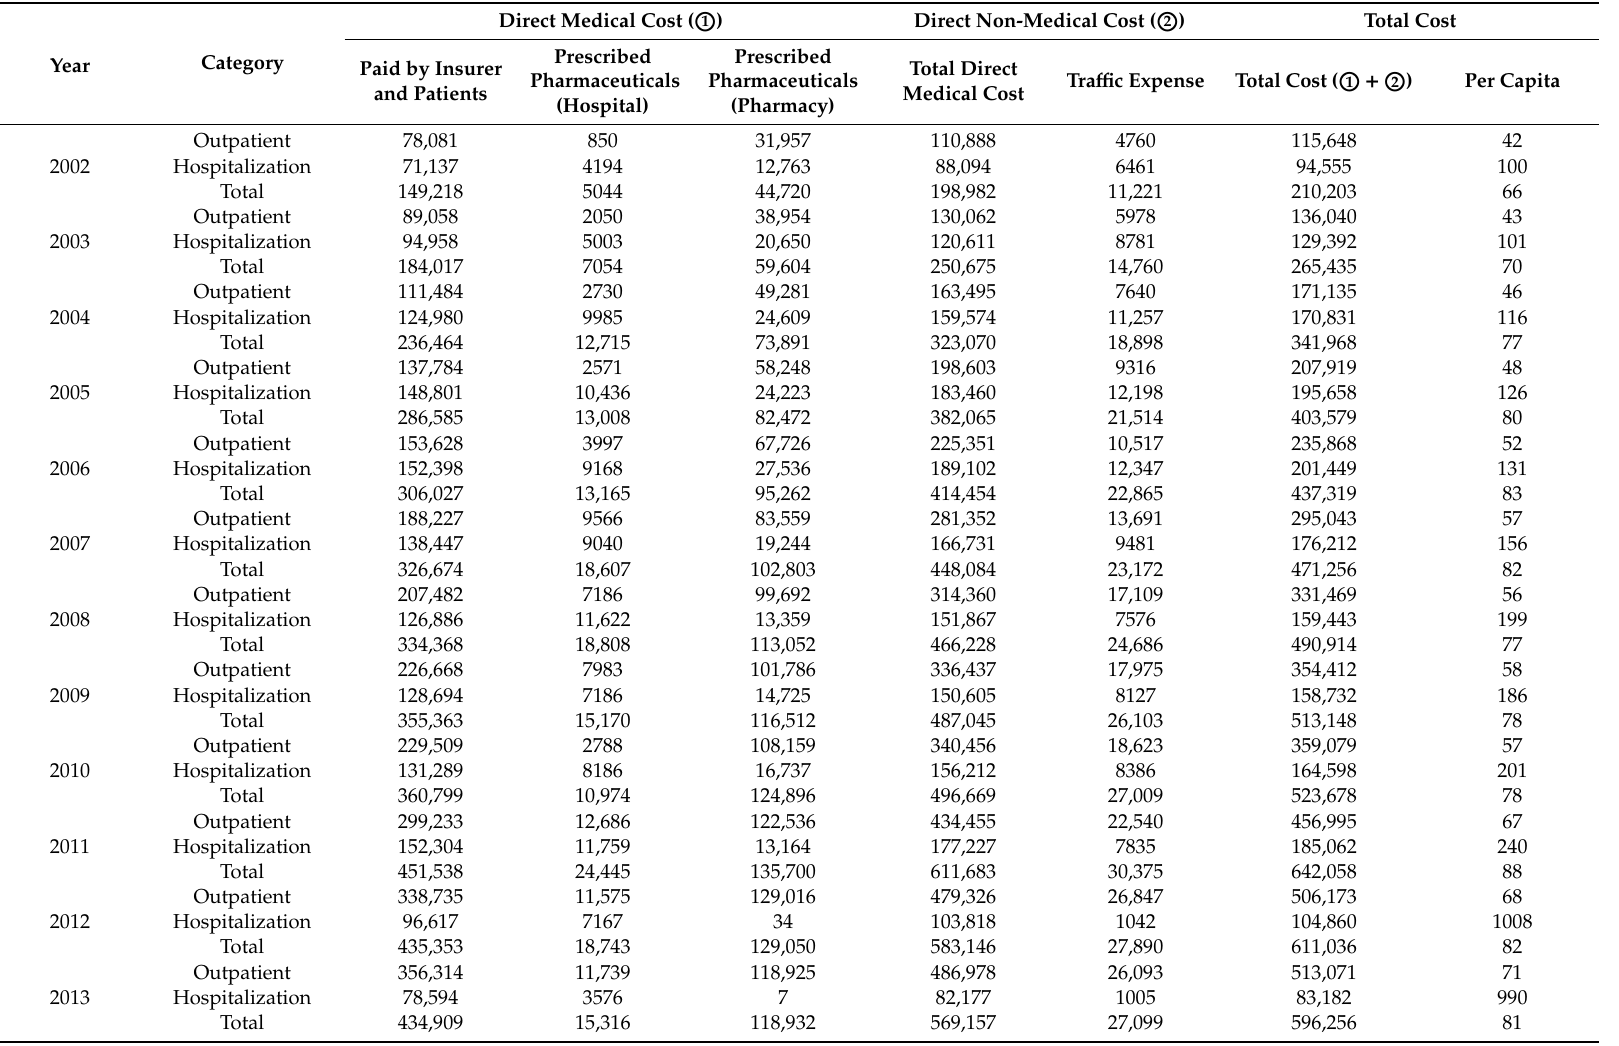
Table 4. Health Expenditures of iron deficiency anemia in Korea,